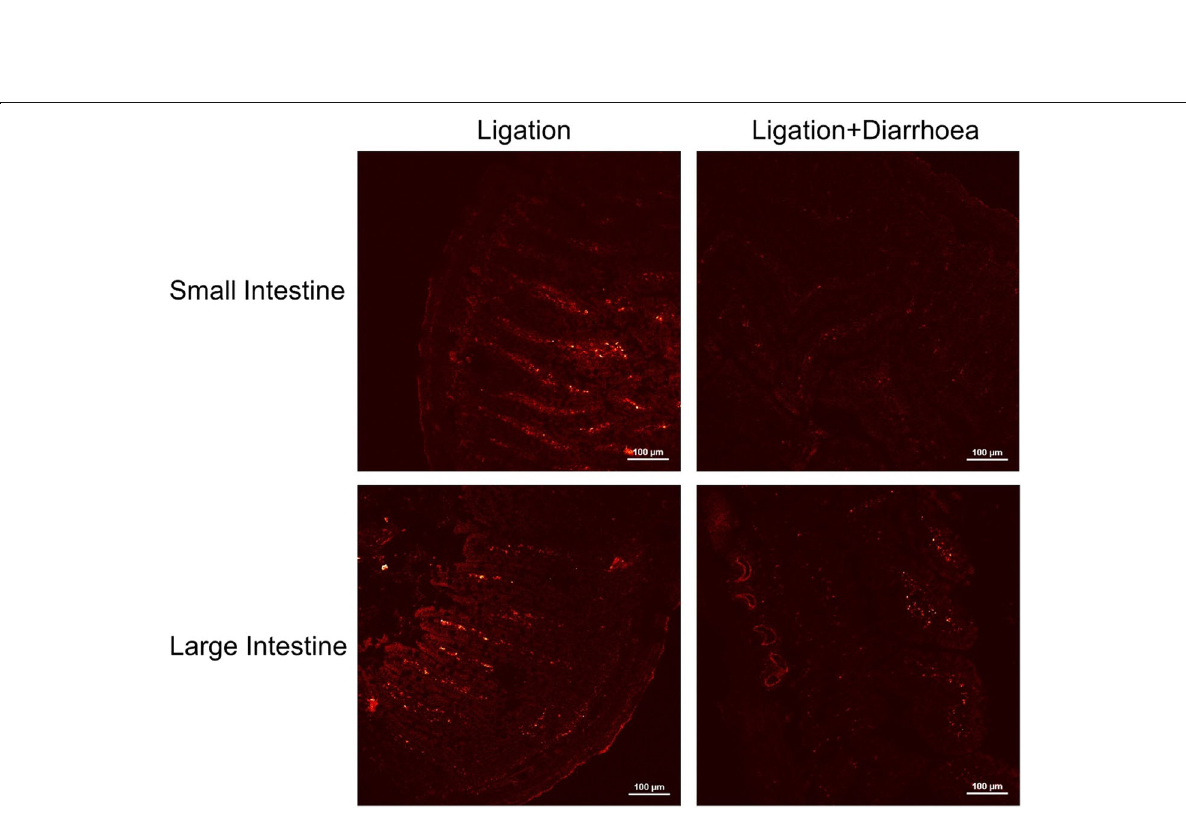
Fig. 7 Two-photon-laser scanning confocal microscopy images of intestinal tissue sections at 7 days after tail vein injection of GNRs (excitation 780 nm, emission 601 – 657